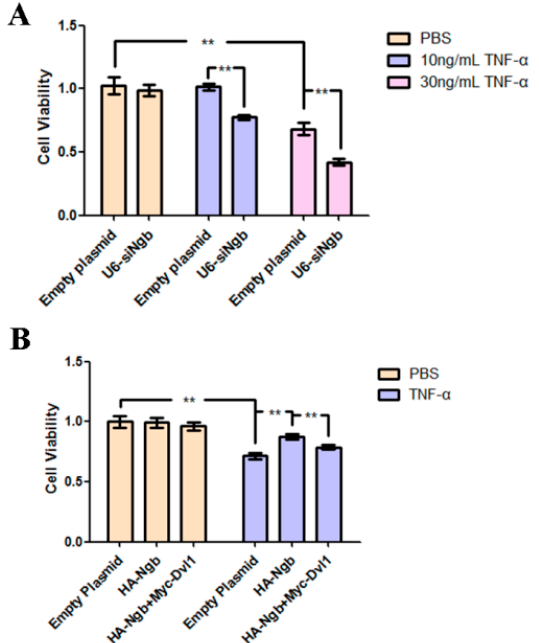
Figure 5. Ngb protects SK-N-SH cells from TNF- α -induced cell death. ( A ) SK-N-SH cells were transfected with empty plasmid (pRNAT-U6.1) or U6-siNgb. After 24 h post-transfection, cells were treated with PBS, 10 ng/mL or 30 ng/mL TNF- α for 24 h. 3-(4,5-Dimethylthiazol-2-Yl)-2,5-Diphenyltetrazolium Bromide (MTT) assay was used to measure cells’ viability. (Mean ± SD). n = 3, ** p < 0.01 versus controls. ( B ) Empty plasmid (pCMV-HA), HA-Ngb or HA-Ngb combined with Myc-Dvl1 was transfected into SK-N-SH cells. After 24 h of post-transfection, cells were treated with 30 ng/mL TNF- α for 24 h. Then MTT assay was used to measure cells viability. (Mean ± SD). n = 3, ** p < 0.01 versus